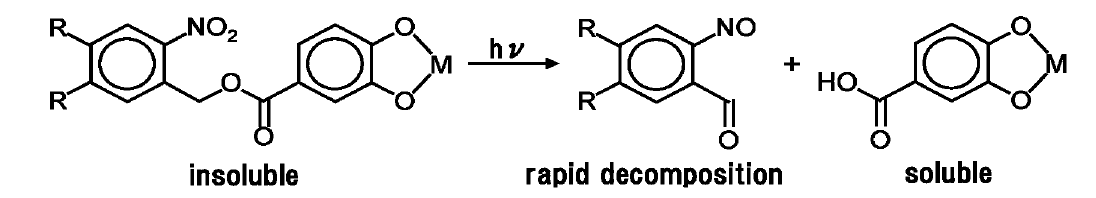
Figure 1. Photo-cleavage of nitrobenzyl ester derived complexes to produce carboxylic acid moiety bearing complexes